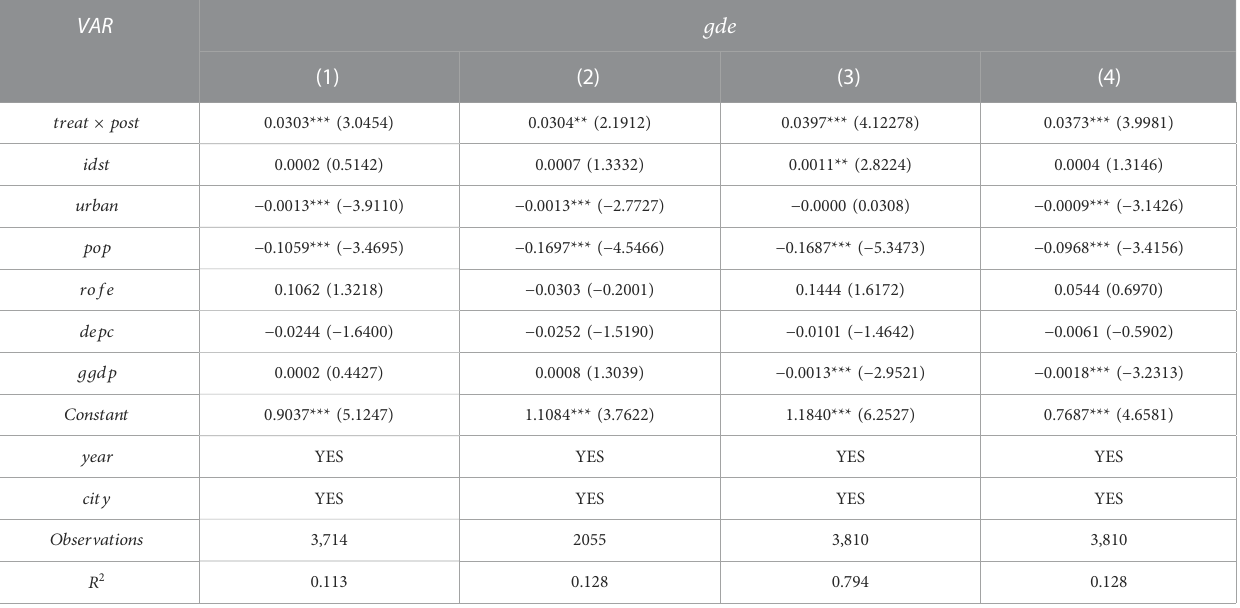
TABLE 3 Robustness